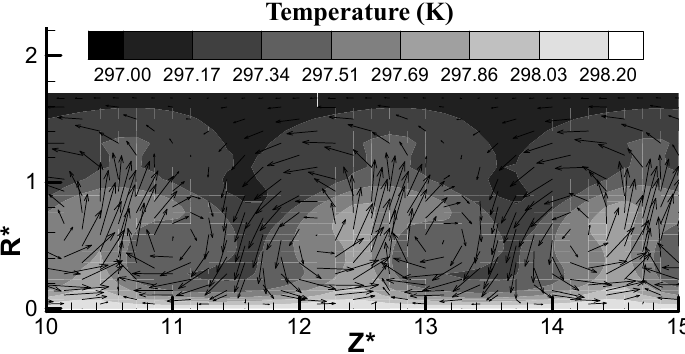
Figure 15. Velocity field and temperature distribution in 6-slit model.